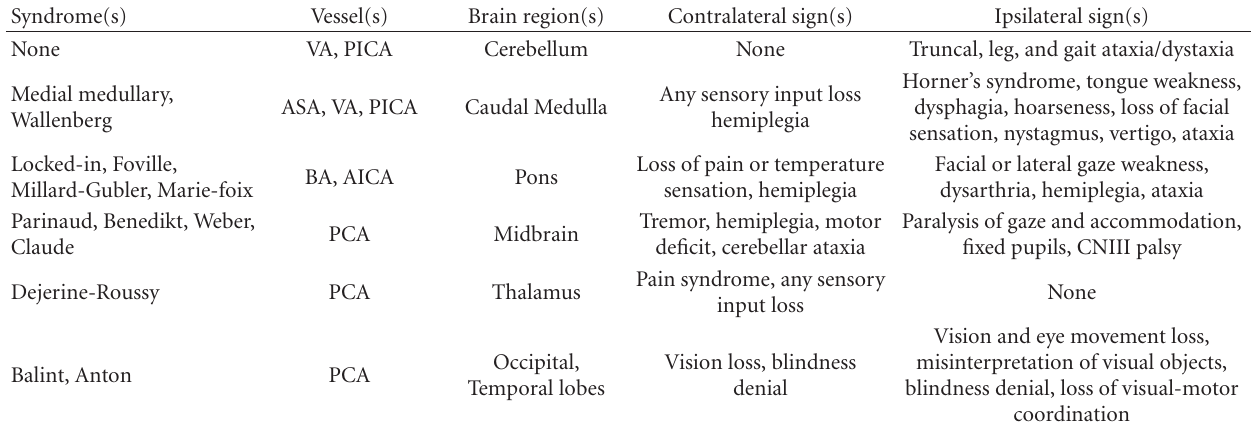
Table 1: Posterior circulation syndromes and associated brain region, clinical